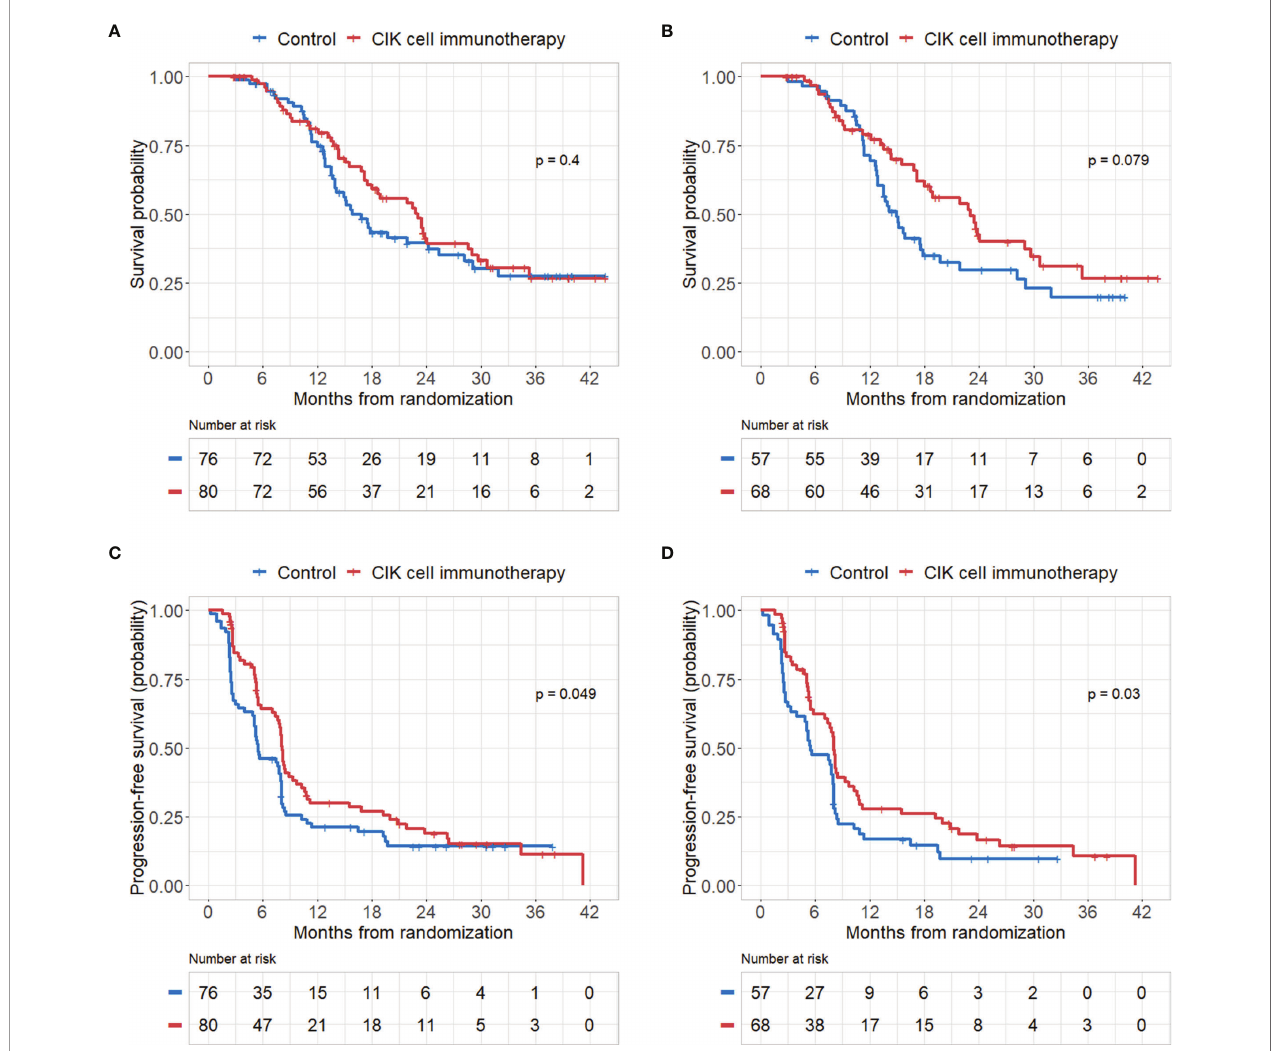
FIGURE 2 | Kaplan – Meier curves of overall survival (OS) and progression-free survival (PFS) rates according to CIK immunotherapy in the mITT population and mITT population with pathologically pure GBM. (A) OS rate according to CIK immunotherapy for patients in the mITT population. (B) OS rate according to CIK immunotherapy for patients with pure GBM in the mITT population. (C) PFS rate according to CIK immunotherapy for patients in the mITT population. (D) PFS rate according to CIK immunotherapy for patients with pure GBM in the mITT